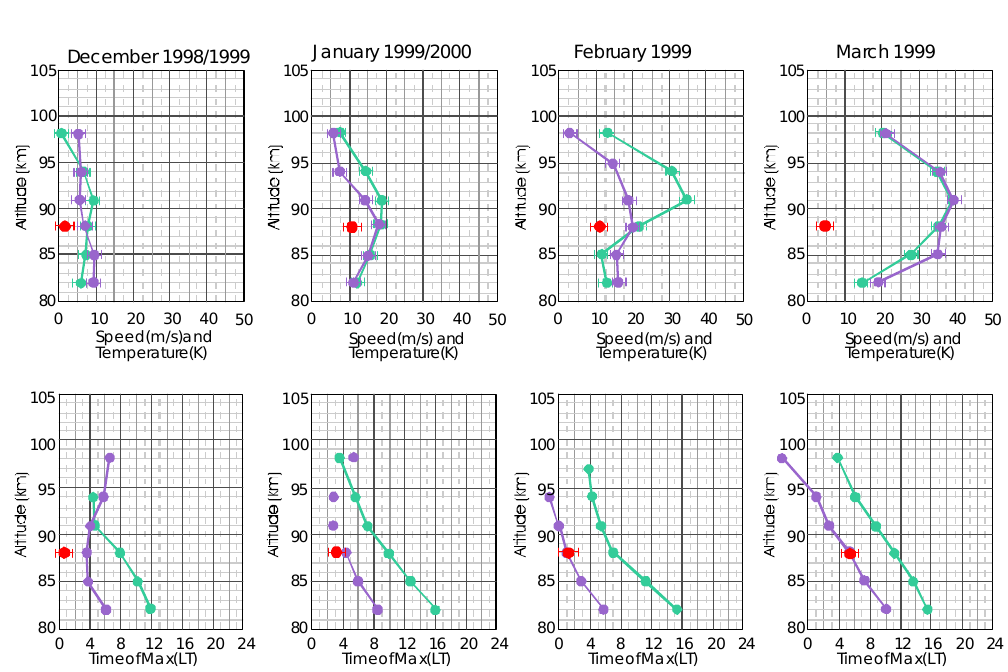
Fig. 2. Graphs showing examples of the diurnal tidal parameters deduced using the meteor radar at Albuquerque, New Mexico (35 ◦ N). Fig. 2 Shown are height profiles of amplitudes and phases for the winds, as well as estimates of the temperature amplitudes and phases at 88 km altitude. The values are seasonal vector averages over several years, as indicated in the table at the base of the figure. Error bars are shown for the amplitudes and the temperature phase. No error bars are shown for the wind phases, since they are less than the sizes of the symbols